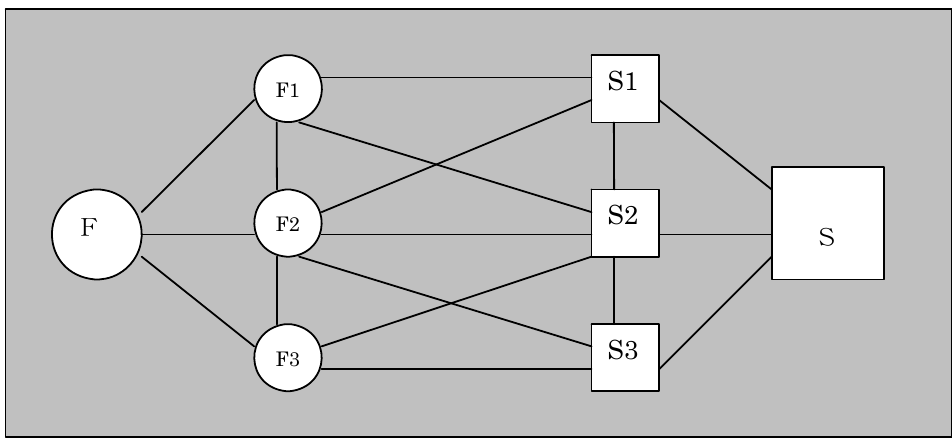
Figure1. Design Methodology and Product